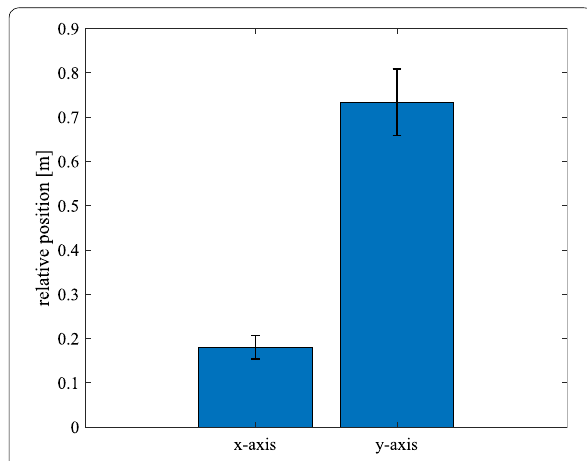
Fig. 9 Relative distance between the user and the robot in the user companion test. Although the user moved appropriately 0.5 m in y-axis in the test, the relative distance was almost constant and its standard division was about 0.075